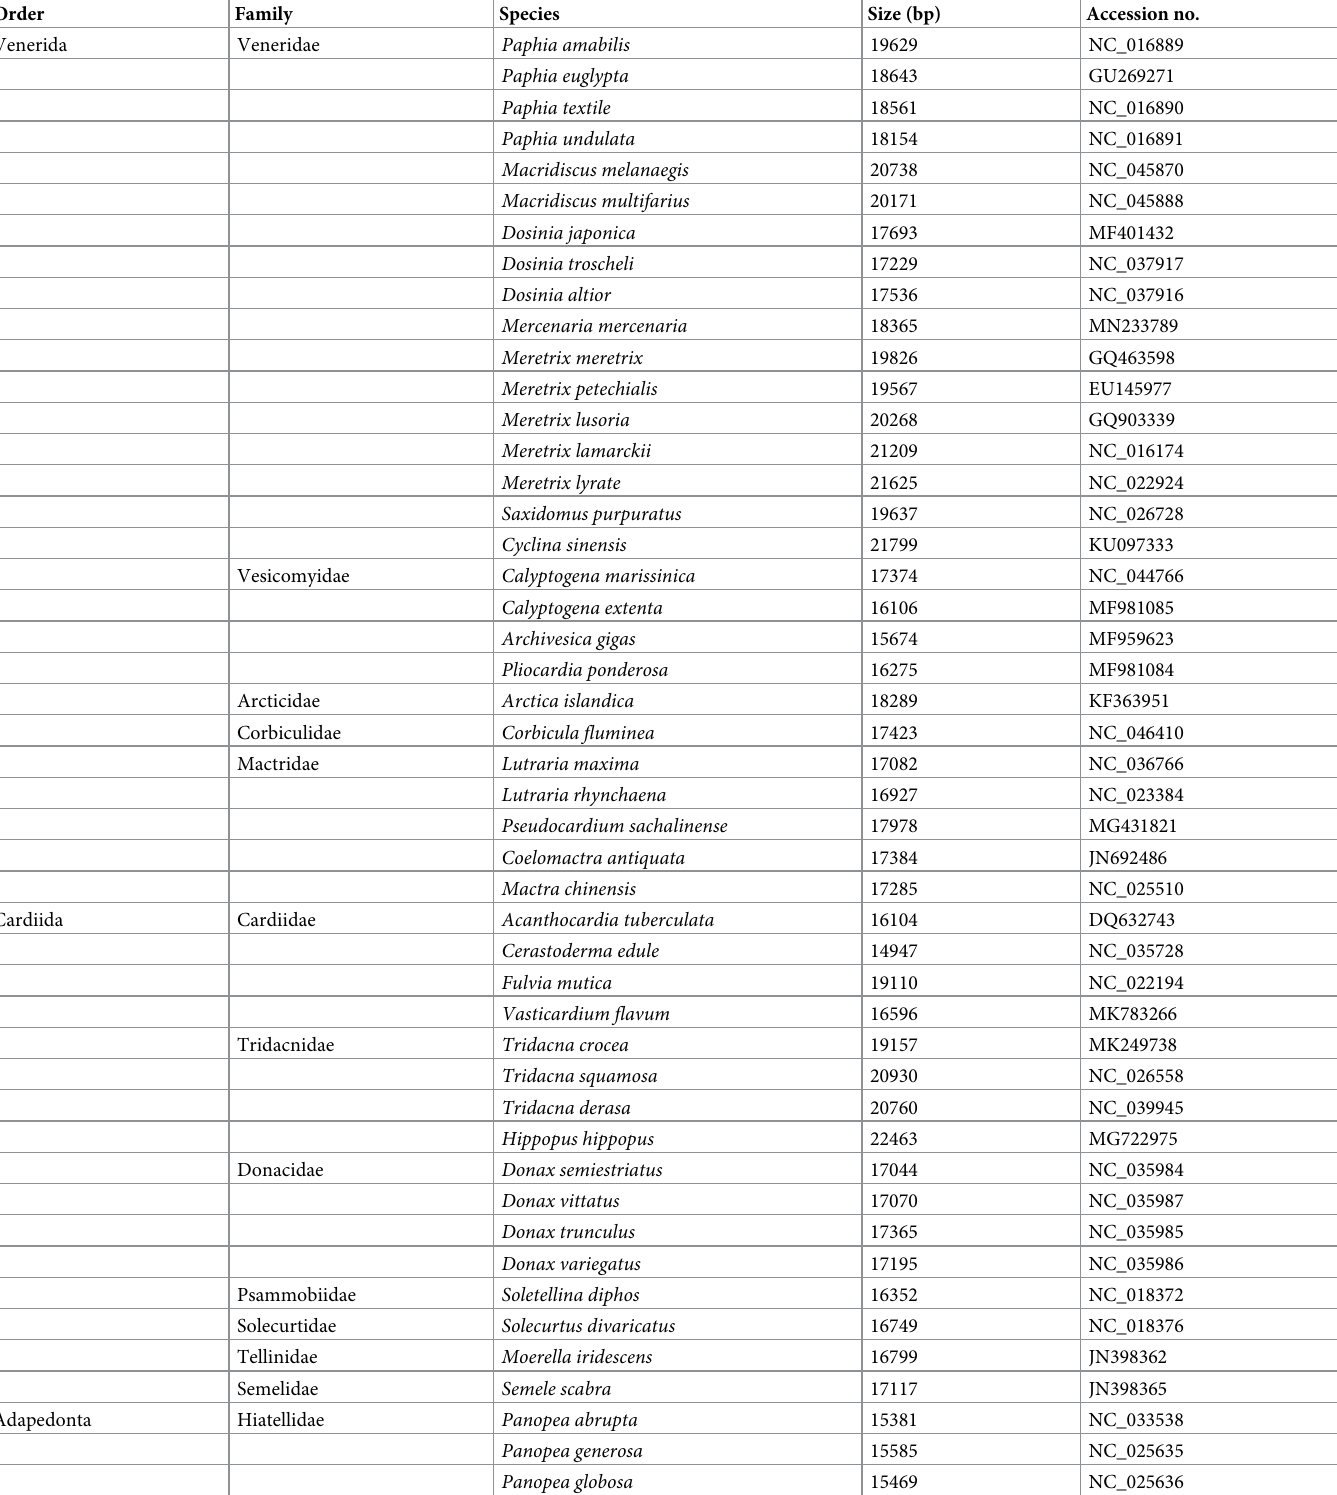
Table 1. List of species analysed in this study with their GenBank accession numbers.